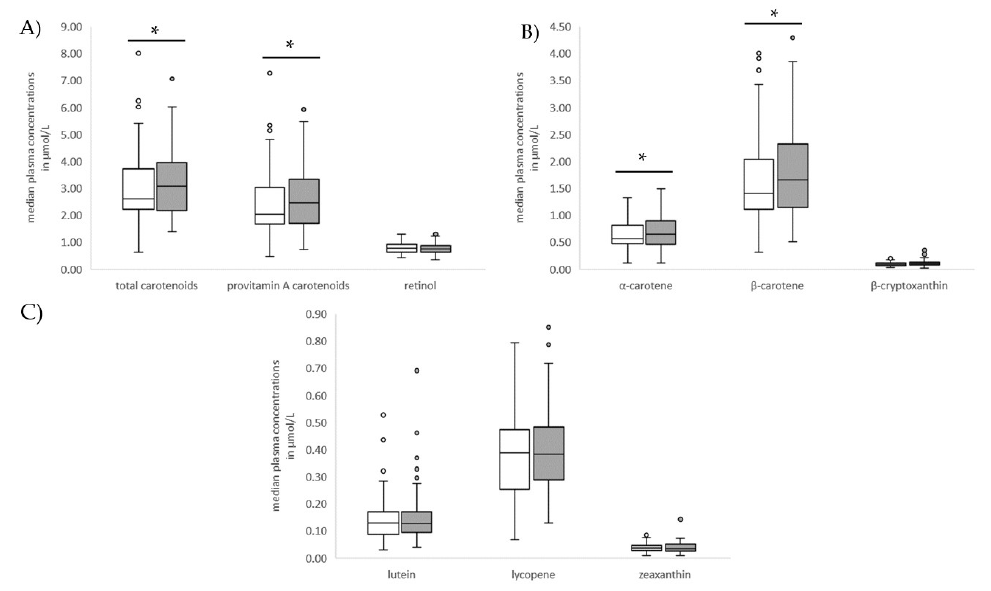
Figure 1. Spearman correlations of calculated food frequency questionnaire-derived nutrient intakes with plasma carotenoid and retinol concentrations; * p < 0.05 .